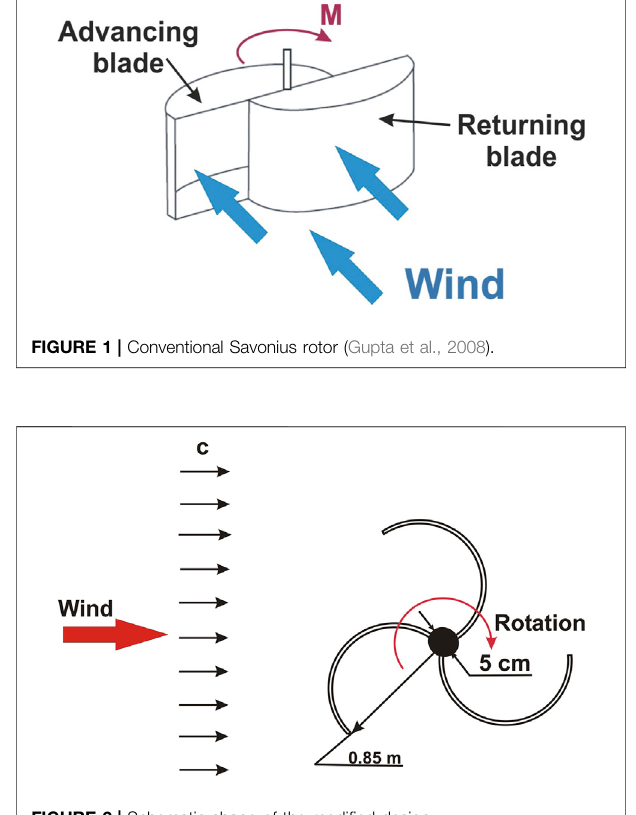
FIGURE 2 | Schematic shape of the modi fi ed design.